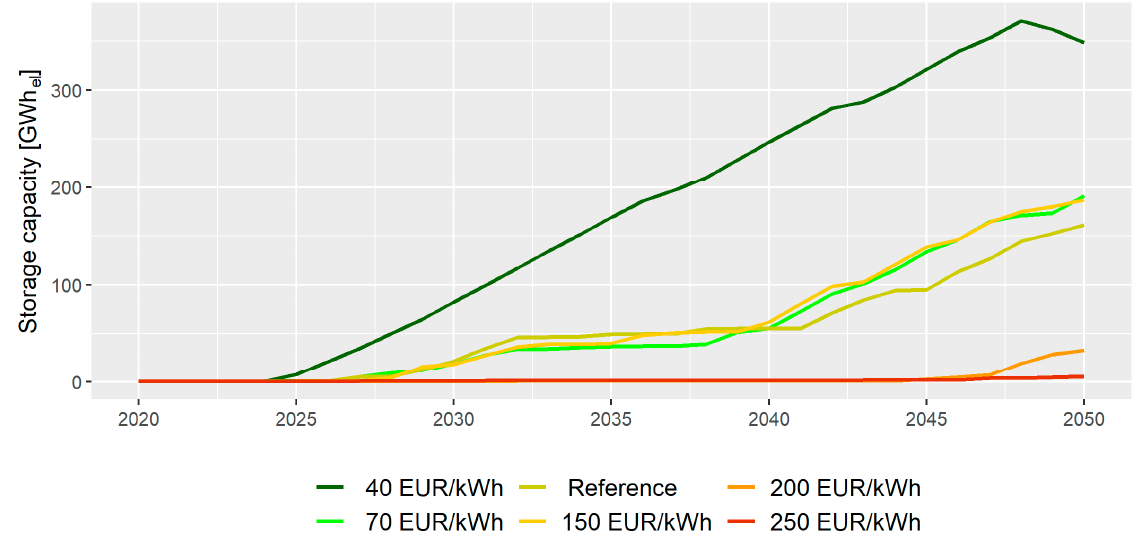
Figure 12. Installed capacities in the calculated scenarios.